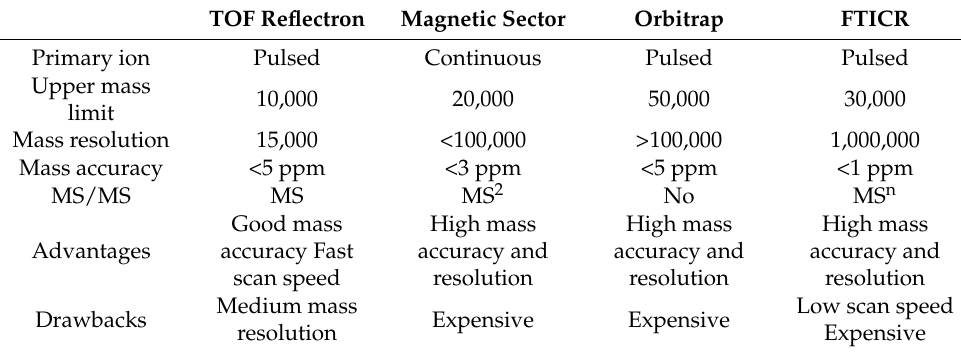
Table 1. General comparison of several common mass analyzers used in MSI. Data obtained from [52,53]. TOF Reflectron Magnetic Sector